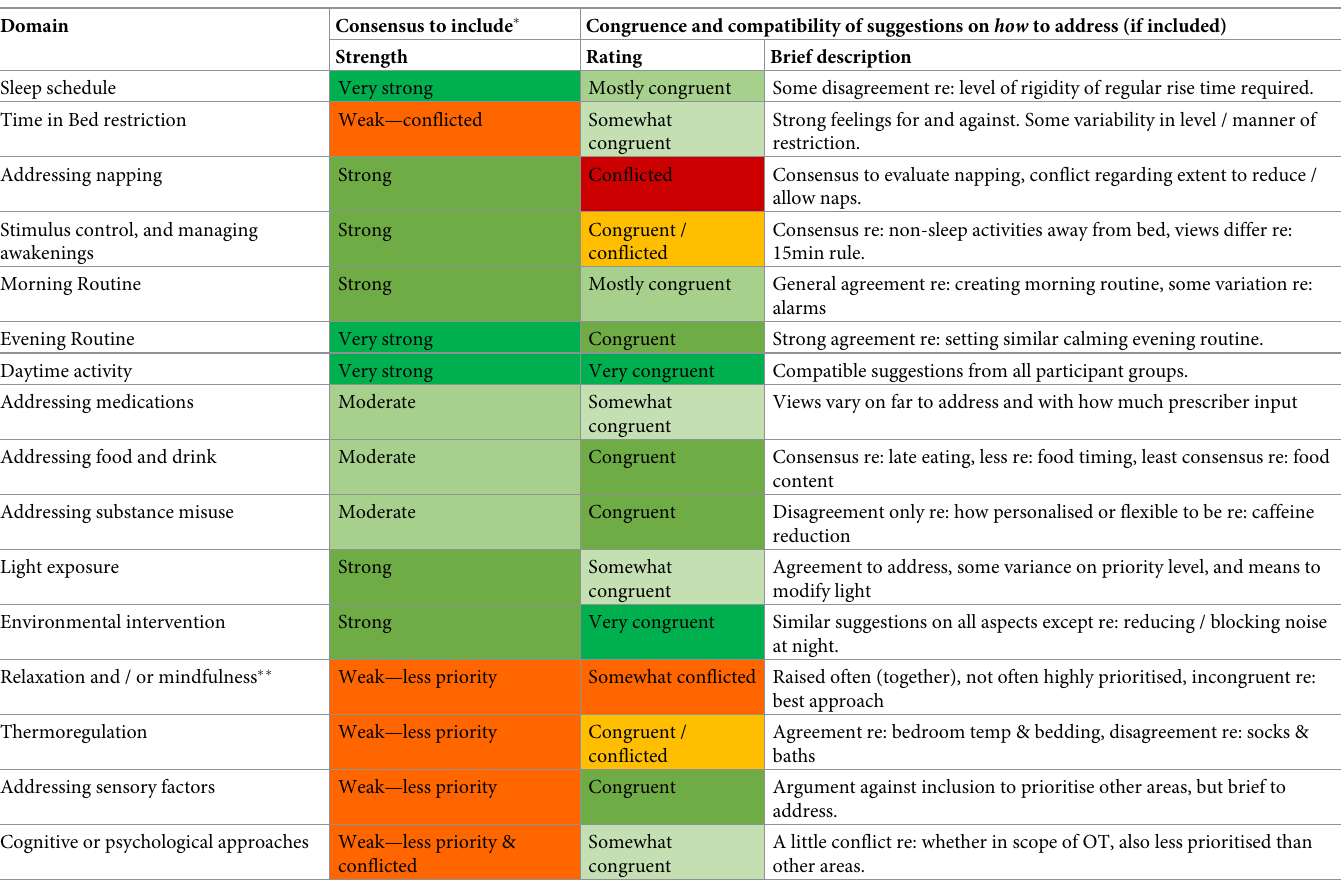
Table 4. Summary of findings regarding intervention domains to address and